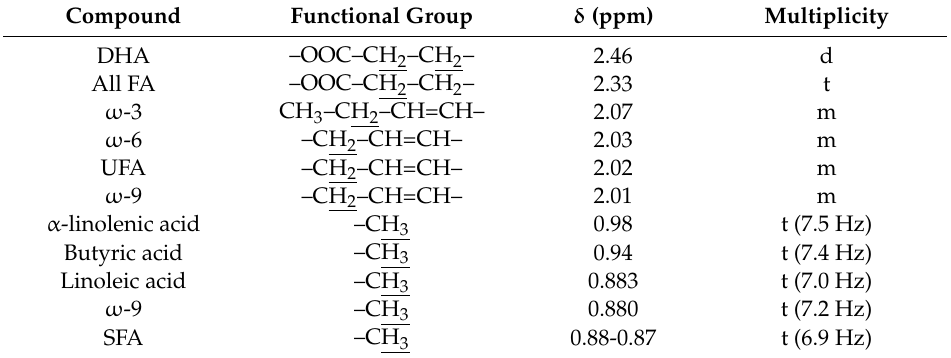
Table 9. 1 H-NMR resonance assignments of allylic protons, α -protons and CH 3 groups in CDCl 3 .